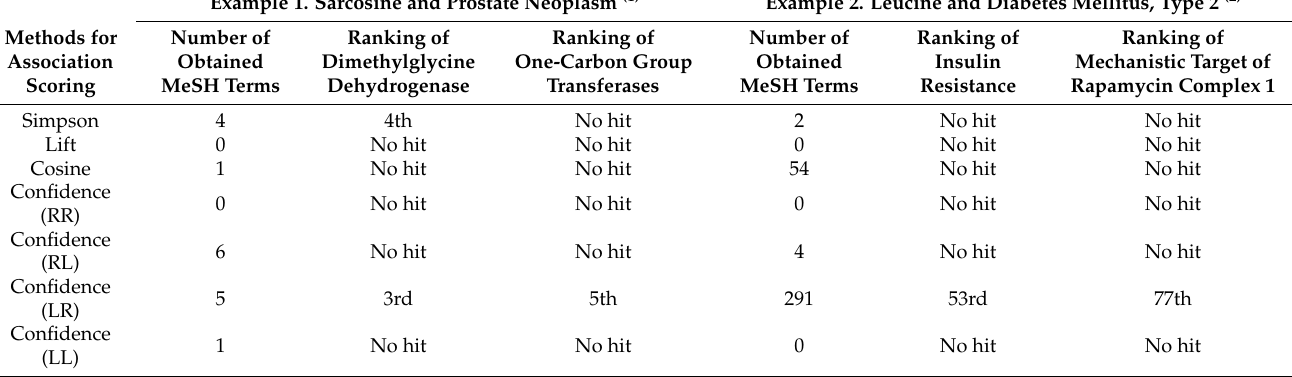
Table 1. Comparison of the scoring methods using two example MeSH terms (false discovery rate level < 0.01).